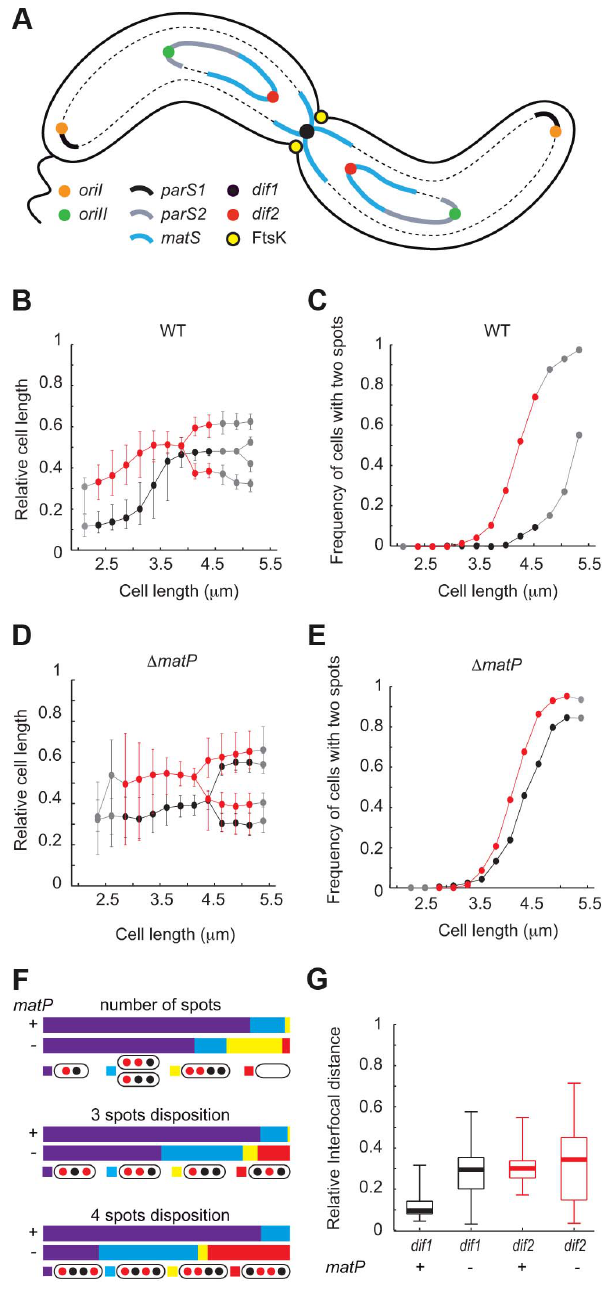
Figure 1. Early segregation of V. cholerae TerII. A. Schematic representation of the two sister chromatids of each of the two V. cholerae chromosomes during septation. B. and D. Relative position of dif1 (in black) and dif2 (in red) along the long axis of the cell as a function of cell length in WT (B) or D matP (D) background. C. and E. Frequency of cells with separated dif1 (in black) and dif2 (in red) sisters as a function of cell length in WT (C) or D matP (E) background. The plain red and black lines show the data for the bins containing at least 30 cells (see Figure S1); the dashed grey lines show the data for bins containing 3 to 29 cells (see Figure S1). F. Upper panel, relative number of cells with a single dif1 and dif2 spot (in purple), a single dif1 spot and two dif2 spots or a single dif2 spot and two dif1 spots (in blue) or two dif1 spots and two dif2 spots (in yellow). Cells without either of these numbers of spots were plotted in the ‘other’ category (in red). Middle panel, in the category of cells with 3 spots, relative number of cells with the depicted dispositions of spots in WT or D matP background.